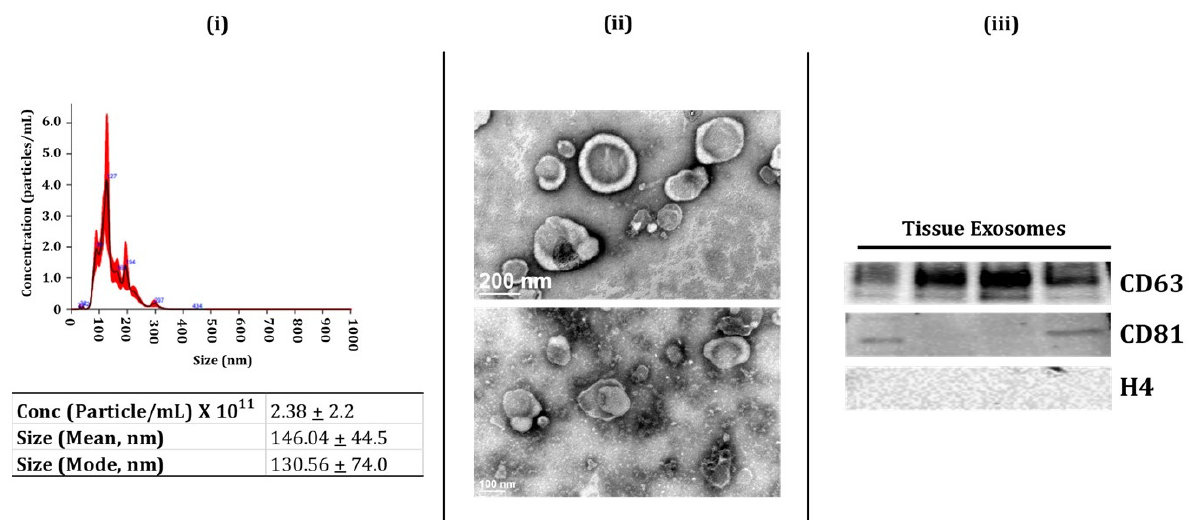
Figure 2. Characterization of human lung ‐ tissue ‐ derived Exosomes (i.e., exosome ‐ enriched EVs. ( i ) Representative image for particle size distribution of lung ‐ tissue ‐ derived exosome in one sample as estimated using NanoSight NS300. Average particle size depicted as mean, mode, and particle concentration in lung ‐ tissue ‐ derived exosome samples ( n = 3–5/group). ( ii ) Representative TEM images of lung ‐ tissue ‐ derived exosomes ( n = 6). ( iii ) Immunoblot analysis of positive (CD63 and CD81) and negative (H4) exosomal markers derived from human lung tissue ( n = 4).